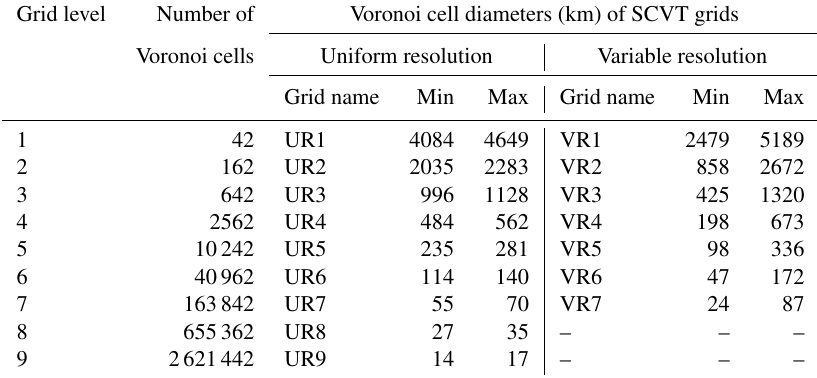
, ε = π and µ = 0 . 8. 45 12